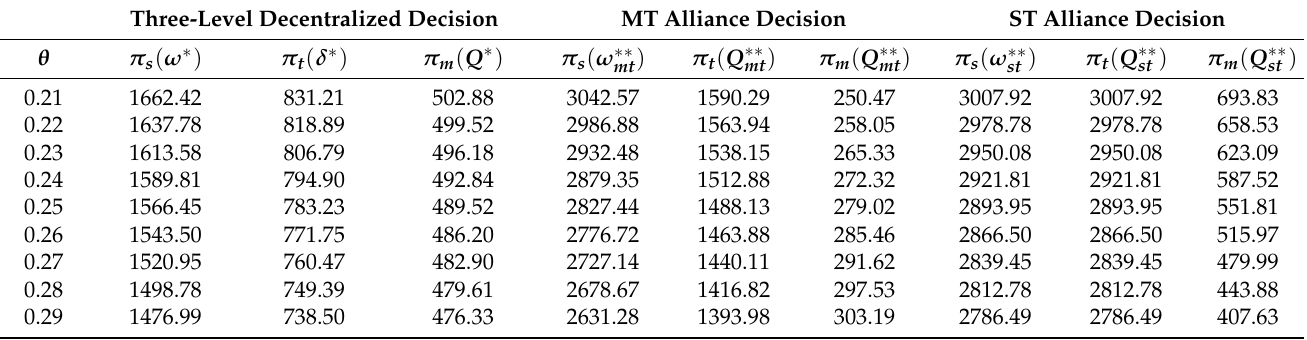
Table 2. Impacts of tariff rate on profits of MT alliance decision, ST alliance decision, and three-level decentralized